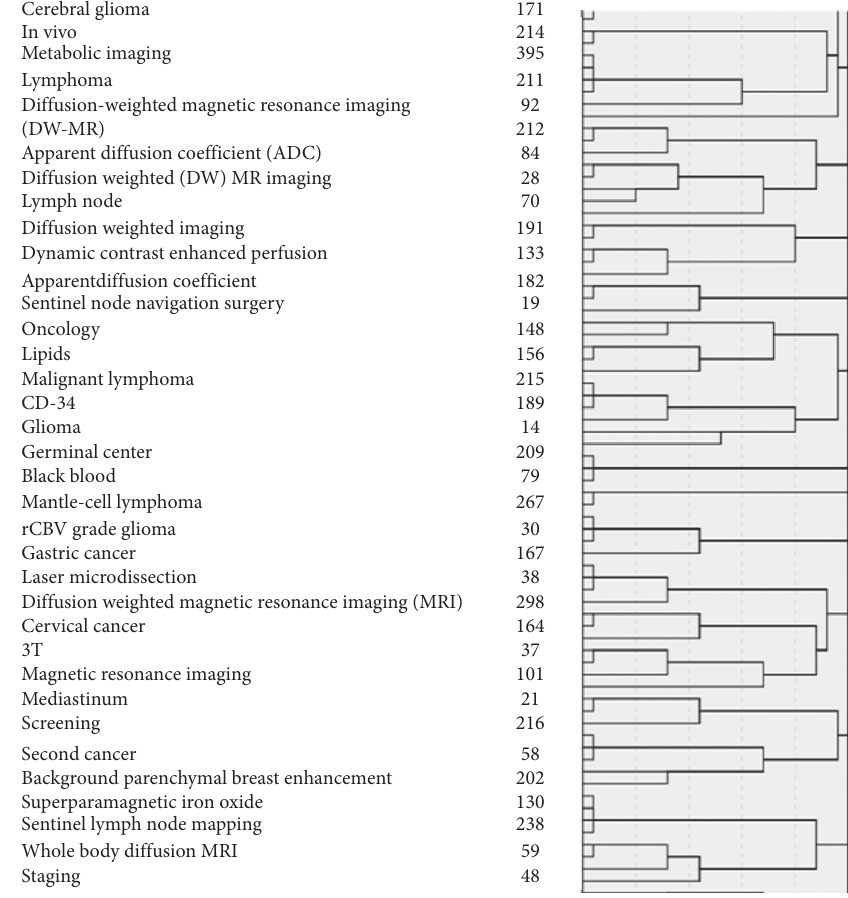
Figure 5: Two-way cluster of